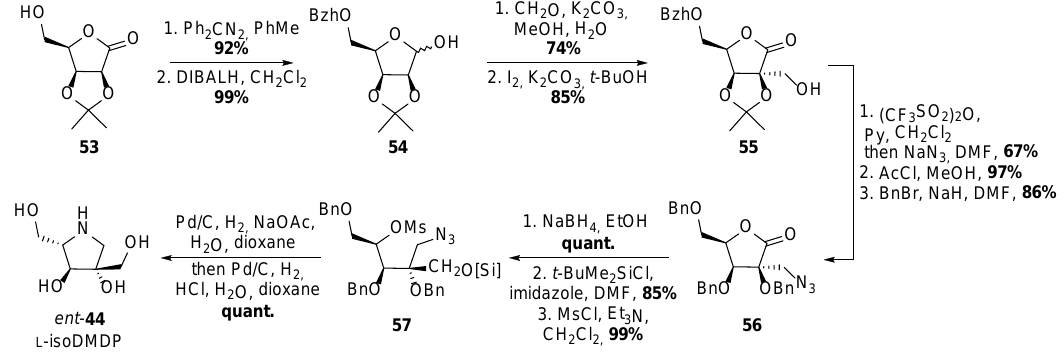
Figure 12. Effect of L -isoDMDP, isoLAB and NBDNJ on the activity of F508del-CFTR in human airway epithelial CF-KM4 cell line, assessed by single-cell fluorescence imaging. ( A ) Cells were incubated with the iminosugars (100 μM, 4 h) in the presence of forskolin/genistein, followed by inhibition with CFTR inh -172. ( B ) Histograms summarizing the results collected from separate experiments. *** p < 0.001. This figure is adapted with permission from [139]. Copyright (2013) American Chemical Society. Dehoux et al. investigated the potential of some carbon-branched pyrrolizidine iminosugars [140,141], i.e., the four diastereoisomers of transalpinecine (± 64 ) and the two diastereoisomers of the epoxide subulacine (± 62 and ± 63 ), as F508del-CFTR correctors. The synthesis of all compounds involved an intramolecular acid-mediated Morita–Baylis– Hillman reaction as the key step (TfOH/Me 2 S) [142], enabling the formation of the bicyclic compound ± 59 from a pyrrolidine scaffold and thereby the access to racemic supinidine (± 60 ) after reduction of the aldehyde function (Scheme 8). Then, double bond epoxidation accomplished via bromohydrin formation led to subulacine ± 62 and its diastereoisomer ± 63 , while the four diastereoisomers ± 64 were obtained by epoxide-ring opening of ± 62 and ± 63 under acidic conditions (TFA/H 2 O) or double bond OsO 4 -catalysed cis -dihydroxylation of ± 59 or ± 60